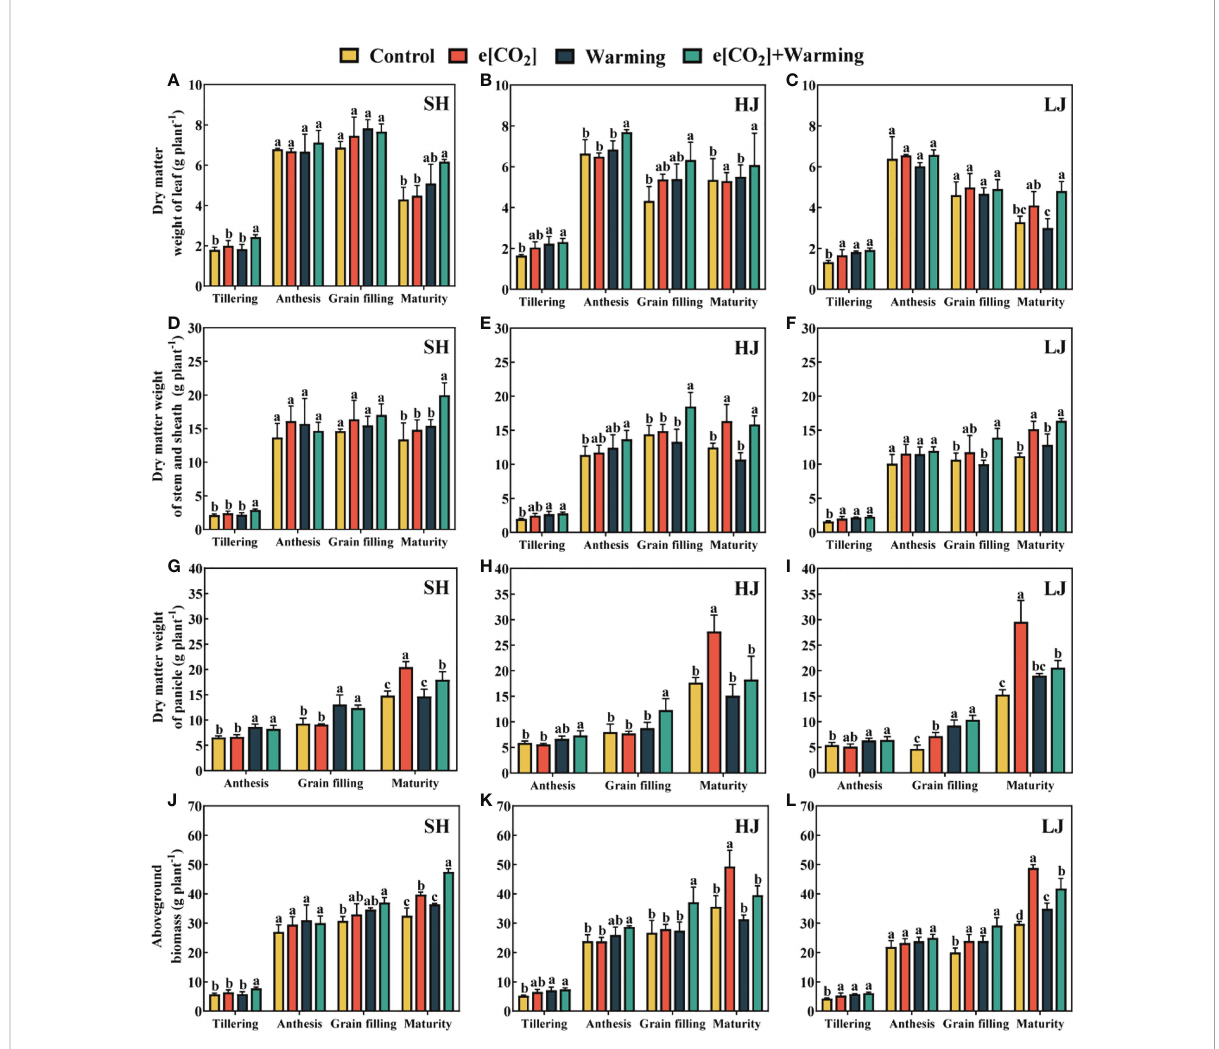
FIGURE 11 The dry matter weight of leaf (A – C) , stem (D – F) , panicle (G – I) and aboveground plant (J – L) at the stage of tillering, anthesis, grain fi lling and maturity under control, ambient conditions; e[CO 2 ], elevated [CO 2 ]; warming, elevated air temperature; e[CO 2 ] plus warming, the combination of elevated air temperature and [CO 2 ]. Values are the means ± SEs (n=3). Lower-case letters indicate signi fi cant differences between treatments at P < 0.05